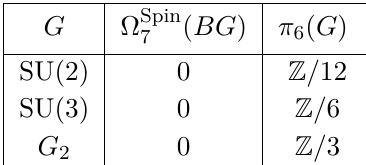
Table 1. Ω versus π for G = SU (2) , SU (3) , and G 2